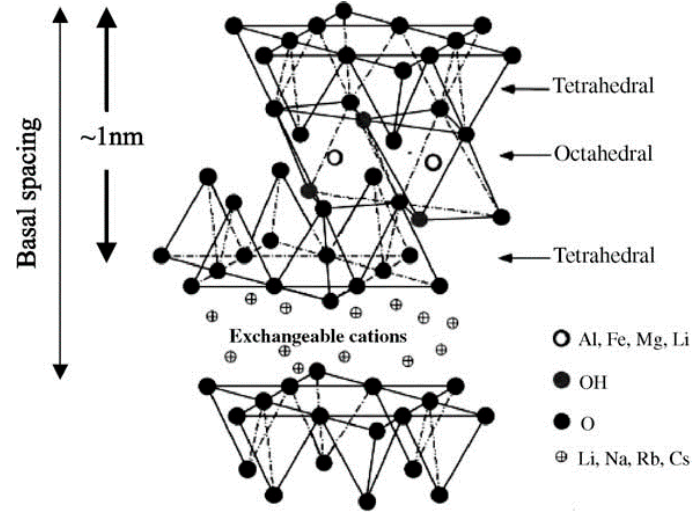
Figure 9. Structure of a 2:1 phyllosilicate (reprinted from [199] with the permission of Elsevier).